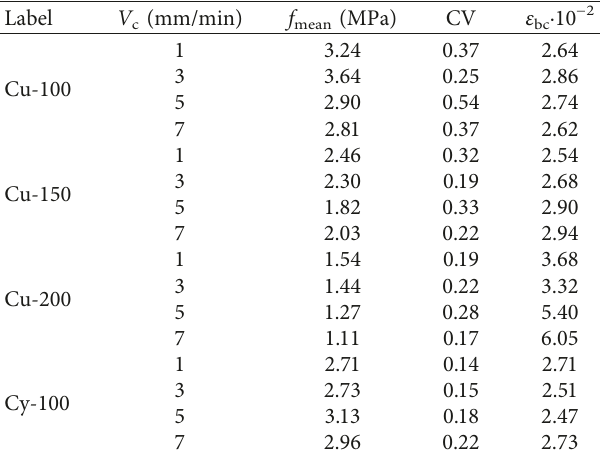
Table 1: Number of specimens.